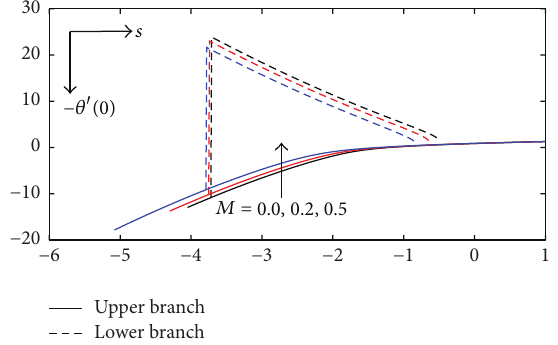
Figure 6: Variation of heat transfer at the surface with 𝑠 for various values of 𝑀 with 𝛾 = 0.5 , 𝜆 = 0.5 , and Pr = 1 .